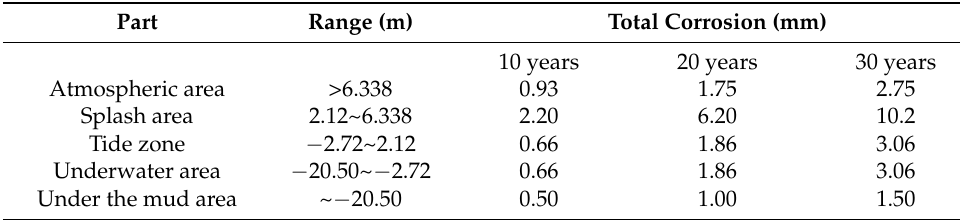
Table 3. Corrosion Table 3. Corrosion parameters.